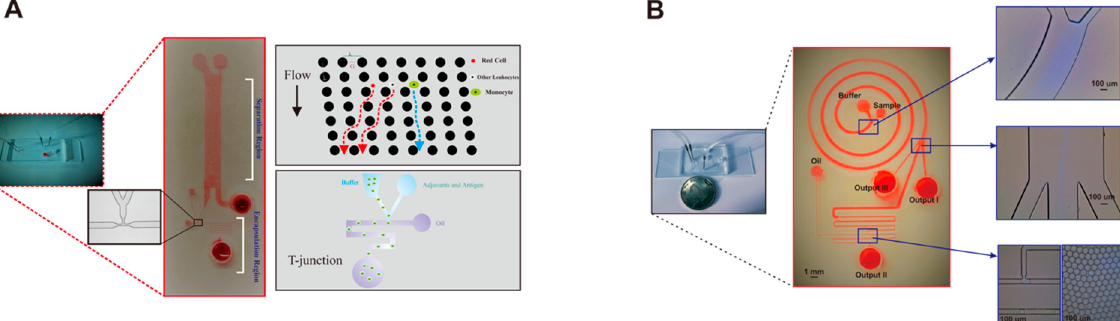
Figure 3. Integrated microfluidic chip for ACT. ( A ) Personalized gel-droplet monocyte vaccines for cancer immunotherapy. Reproduced with permission from Zhang et al., Lab Chip 21(22), 4414–4426 (2021). Copyright 2021 The Royal Society of Chemistry [26]. ( B ) Non-invasive T cell-adoptive immunotherapy for solid tumor with gel anti-tumor T cell injections. Reproduced with permission from Zhang et al., Chemical Engineering Journal 439, 135839 (2022). Copyright 2022 Elsevier